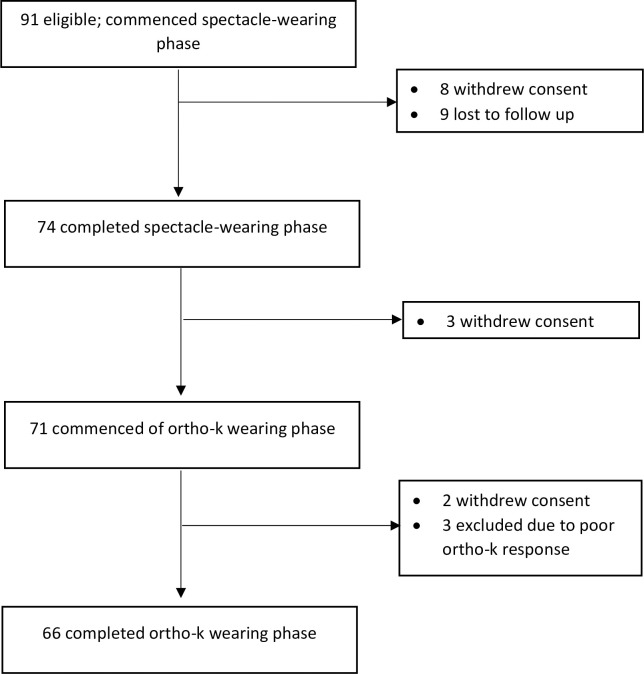
Study flowchart.